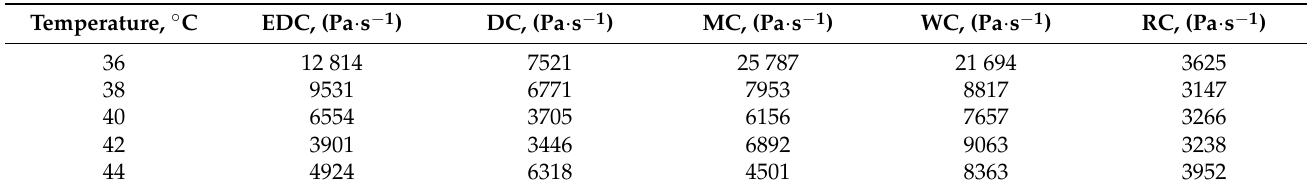
Table 6. Hysteresis values of the chocolate masses ( n =